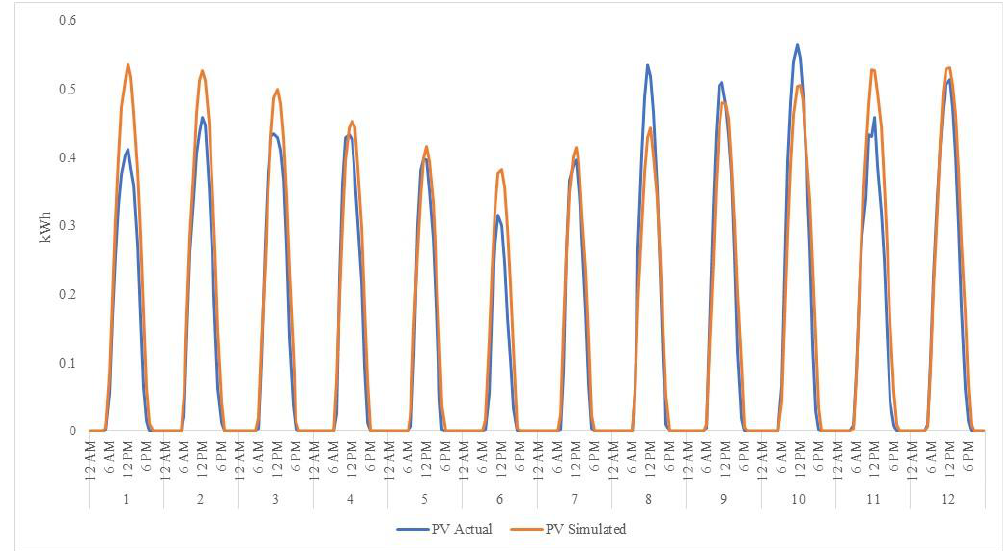
Figure 8. Simulated and historical PV generation, 1.5 kW PV system daily half hour averages by month.